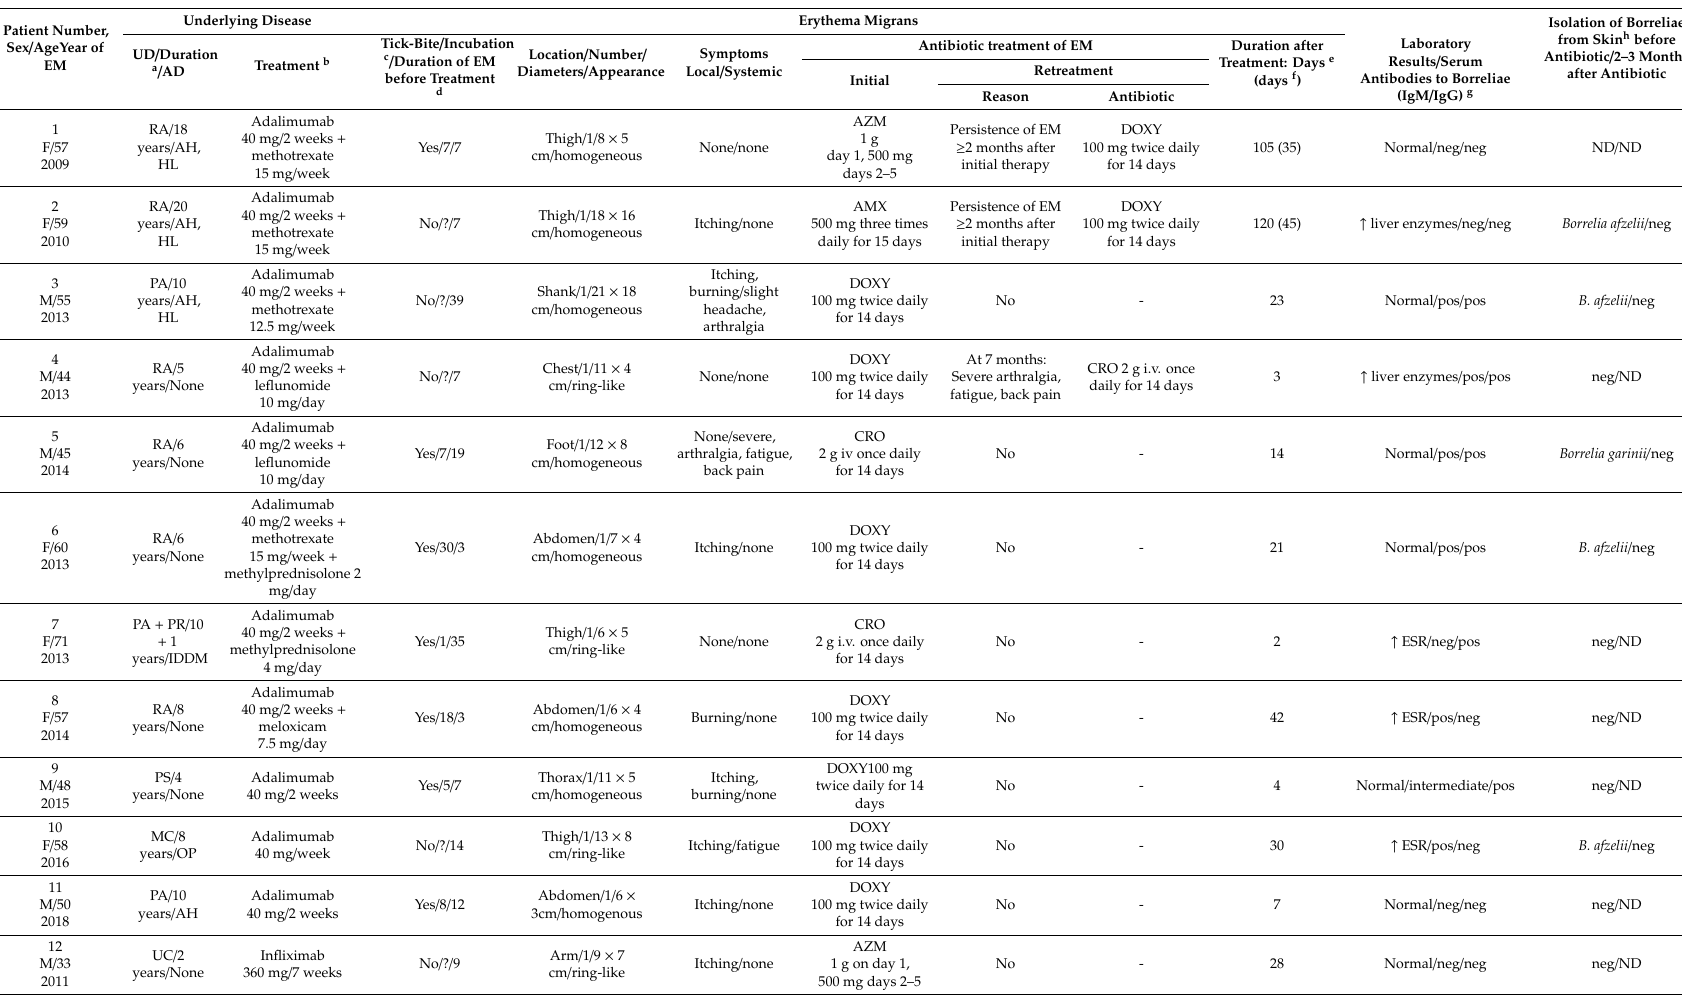
Table 1. Clinical and epidemiological data on 16 patients who developed solitary erythema migrans during treatment with tumour necrosis factor alpha (TNF- α ) inhibitors for their underlying